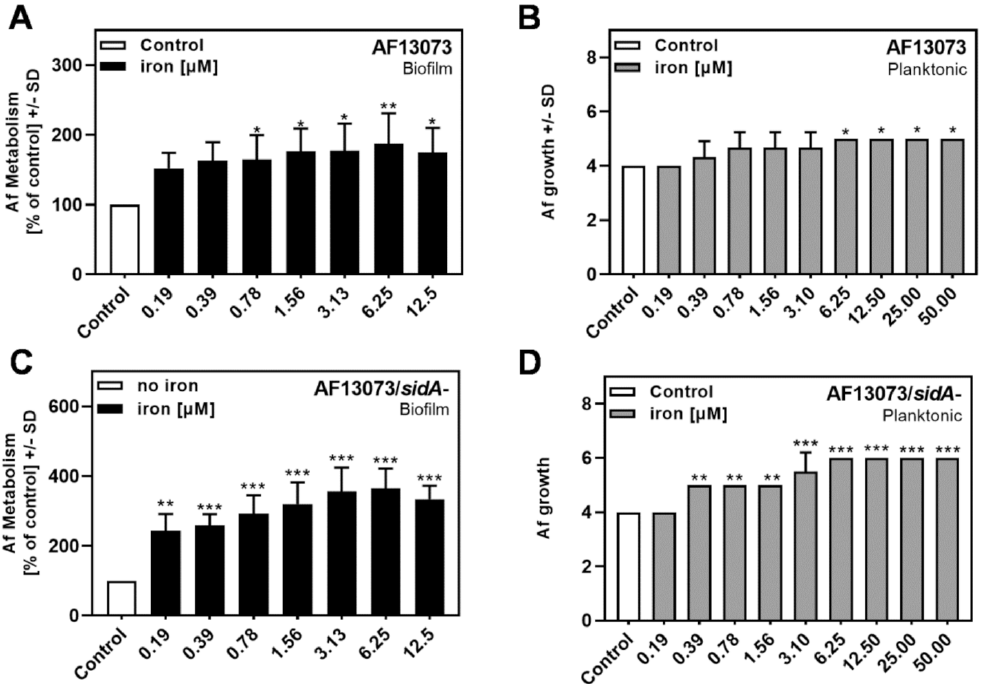
Figure 4. Iron induces the metabolism and growth of A. fumigatus . FeCl 3 (iron; final concentrations 0.19–12.5 µ M in RPMI 1640 medium, x-axis) was combined with ( A , B ) AF13073 conidia or ( C , D ) AF13073/ sidA - conidia. ( A , C ) For the measurement of biofilm metabolism, plates were incubated at 37 ◦ C overnight. Fungal metabolism was measured by an XTT assay. ( B , D ) The tubes for planktonic fungal growth were incubated at 37 ◦ C for 48 h. Fungal growth was measured visually, and rated as described in the Material and Methods section. Biofilm metabolism or planktonic growth in the presence of RPMI alone was compared to each iron concentration. Statistical analysis, 1-way ANOVA: one, two or three asterisks = p ≤ 0.05, p ≤ 0.01 or p ≤ 0.001,